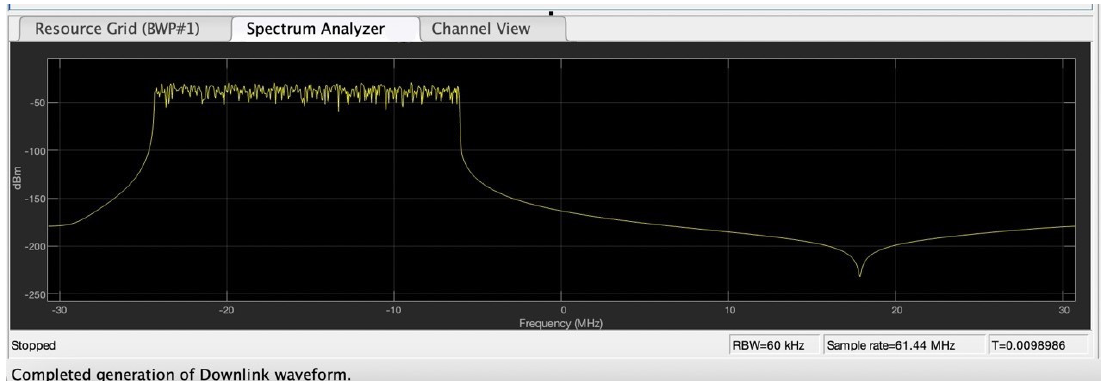
Figure A3. The 5G signal set by the developer.